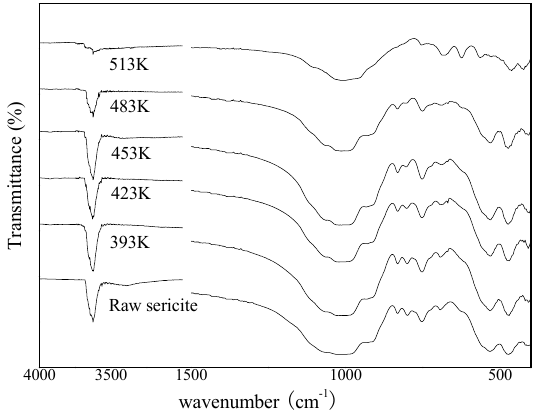
Figure 4. FTIR spectrum of alkali leached residue treated at different alkali leaching temperature.